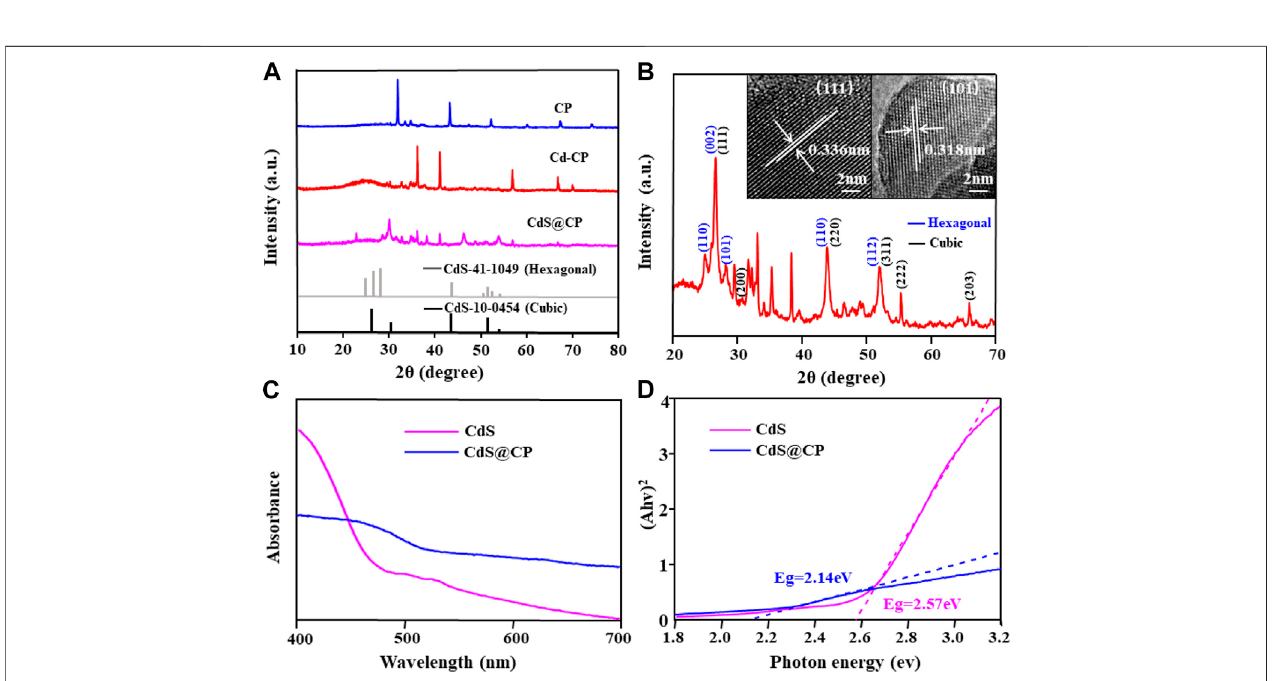
Frontiers in Chemistry |